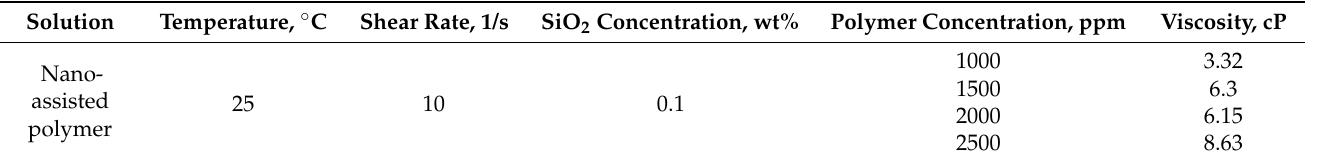
Table 9. Rheology of nanofluid/polymer solutions.